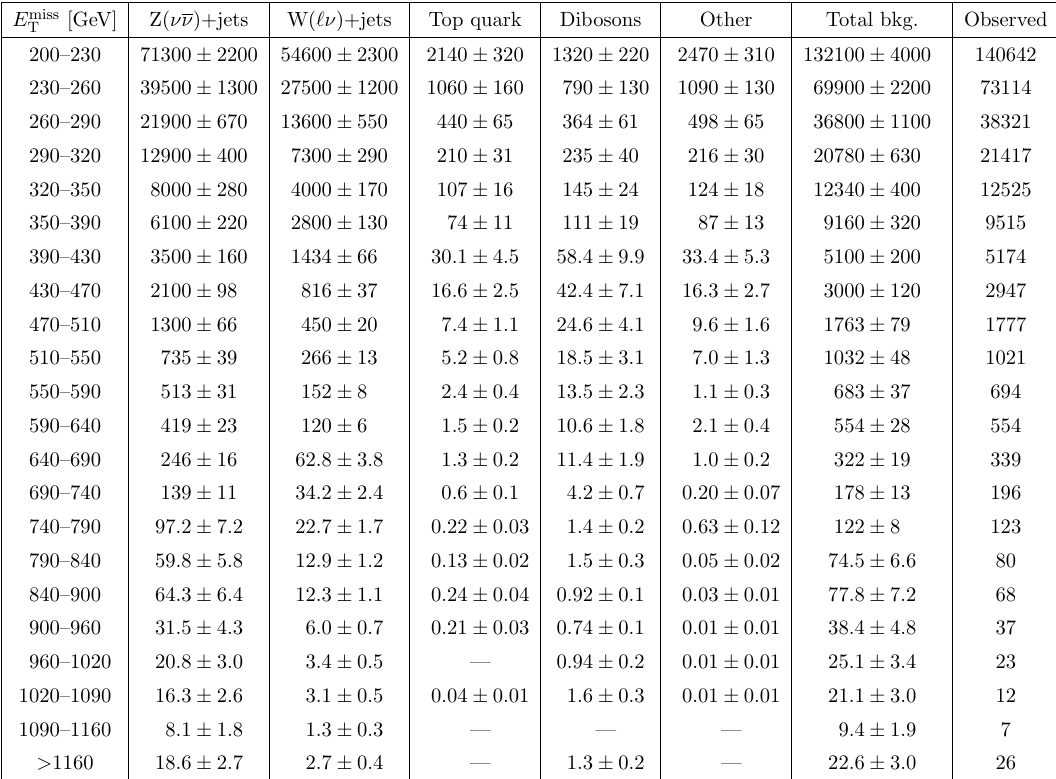
Table 3 . Expected event yields in each E miss bin for various background processes in the monojet T signal region. The background yields and the corresponding uncertainties are obtained after per- forming a combined (cid:12)t to data in all the control samples, but excluding data in the signal region. The observed event yields in the monojet signal region are also reported.